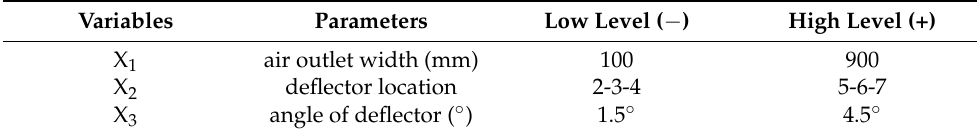
Figure 20. Schematic diagram of an RBF neural network. Table 3. Design factors and their levels.